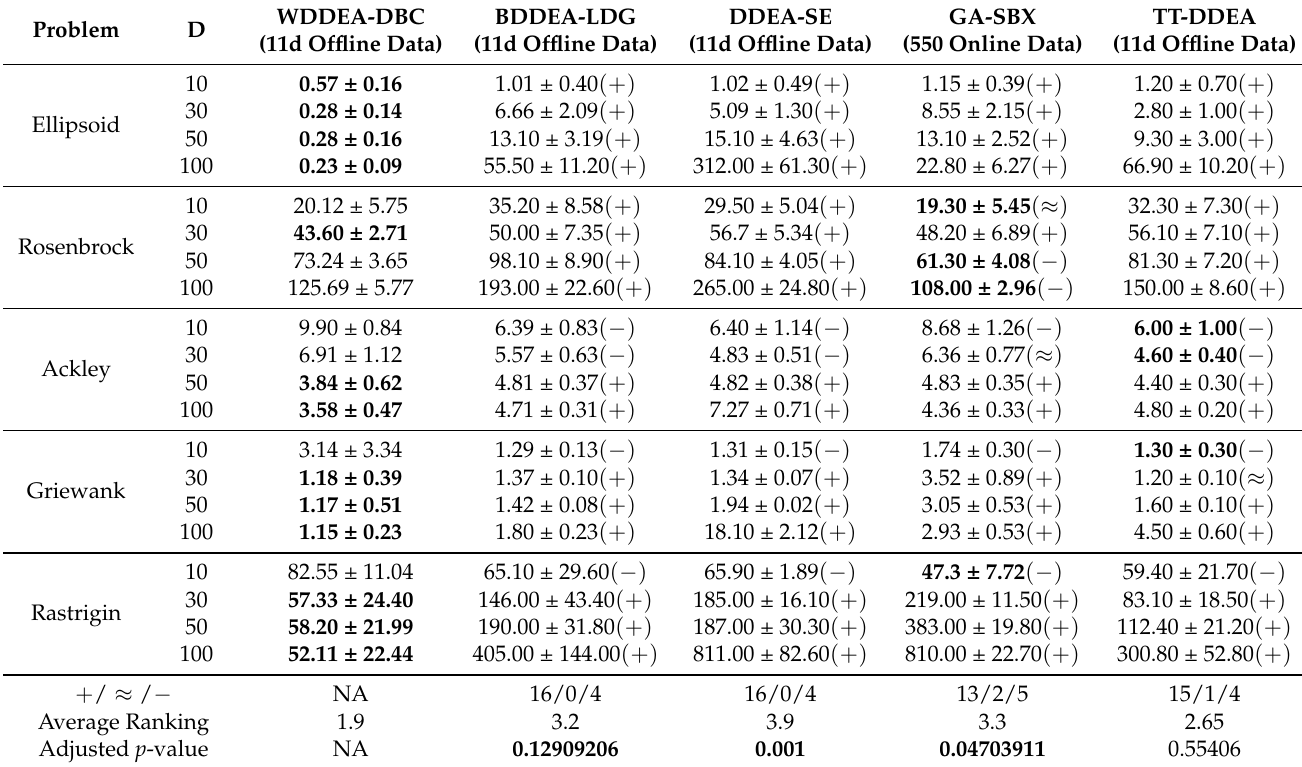
Table 4. The comparisons on optimization results between the proposed algorithm and other repre- sentative DDEAs (the best results and the lowest p -values are shown in